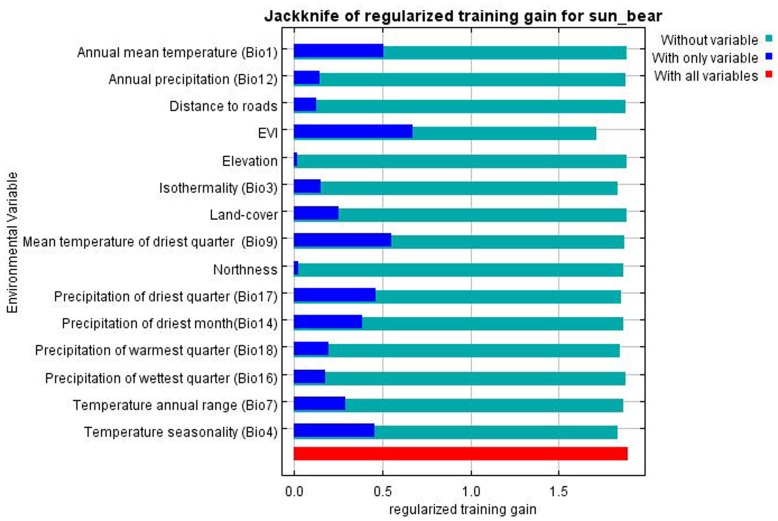
Results of jackknife test of relative variable importance of predictor variable for MSB.The plot shows how environmental variables can increase or reduce the gain when solely used or omitted. EVI has the highest gain in isolation, and also reduces the gain the most when omitted.